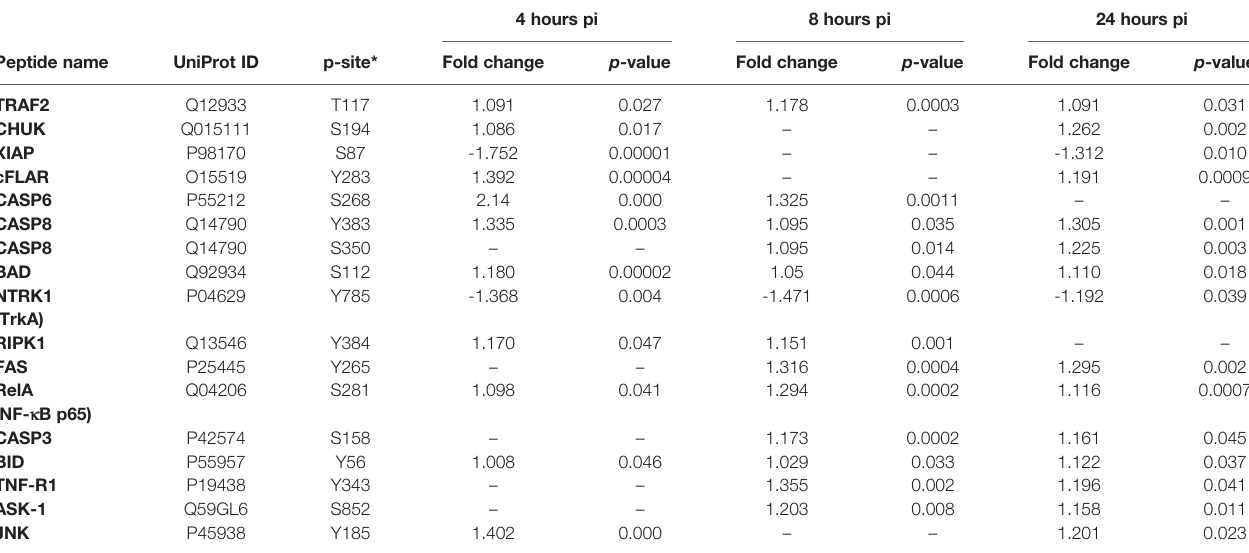
TABLE 7 | Members of the apoptosis signaling pathway showing differential phosphorylation between Salmonella enterica serovar Enteritidis-infected cecal tissue and non-infected cecal